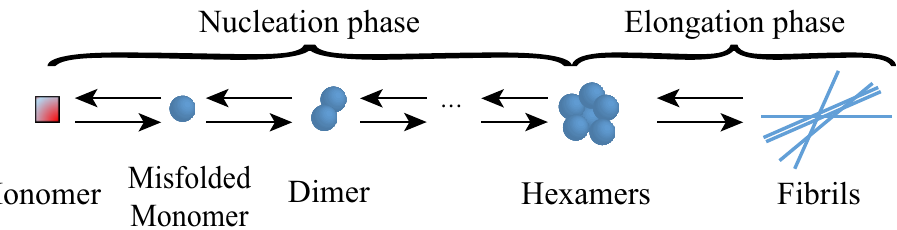
Figure 1. The two phases (nucleation phase and growth/elongation phase) of amyloid formation.